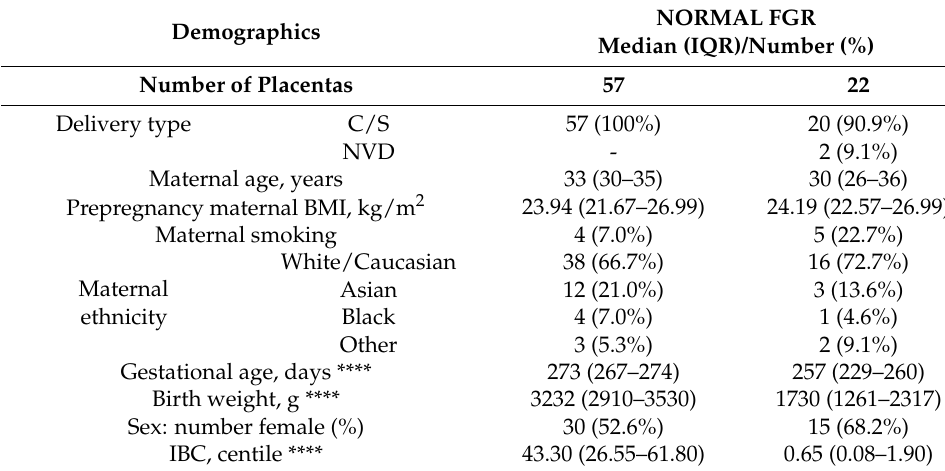
Table 1. Demographic details of placenta